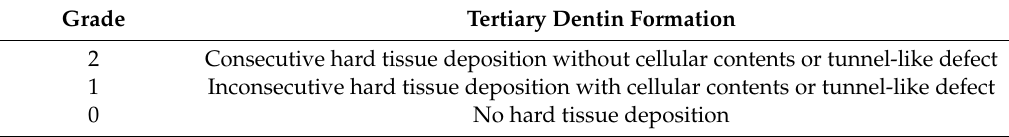
Table 1. The criteria used for the histological analysis of tertiary dentin